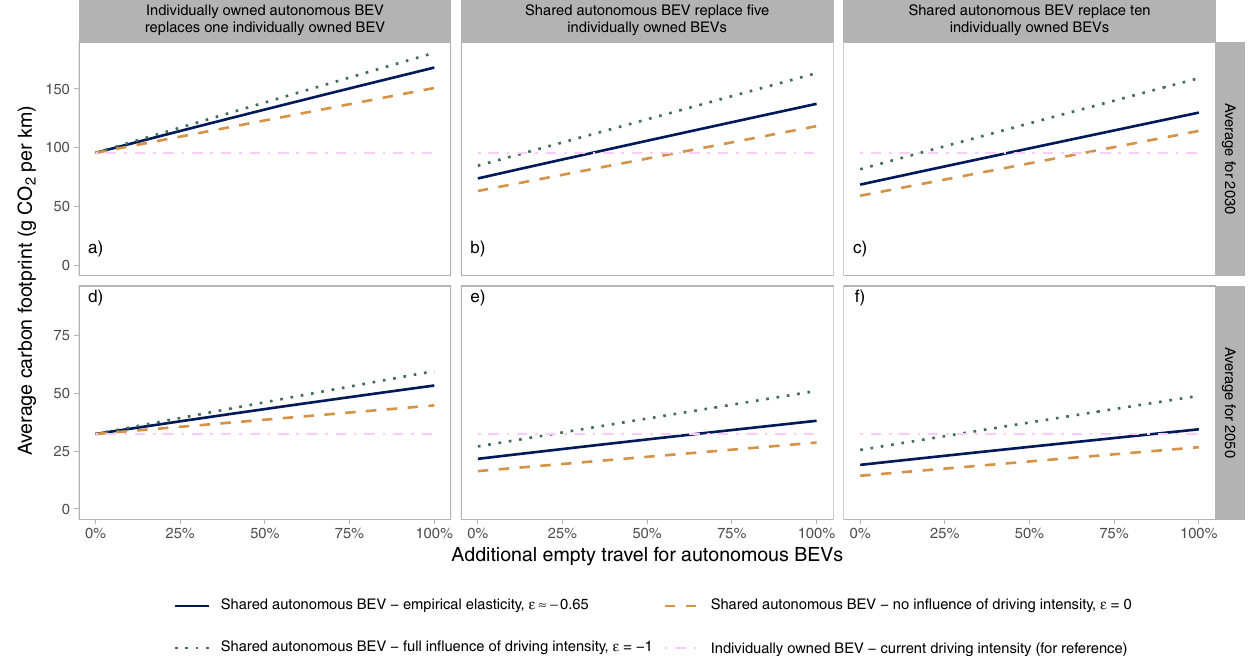
dotted:sharedautonomousBEV – fullin fl uenceofdrivingintensity, ε = − 1,dashed: shared autonomous BEV – no in fl uence of driving intensity, ε = 0, and dot-dashed: individuallyowned BEV – current driving intensity). a – c Show results for 2030 and d – f show results for 2050. The results assume that global manufacturing and electricity generation decarbonize in line with the Paris Agreement ’ s